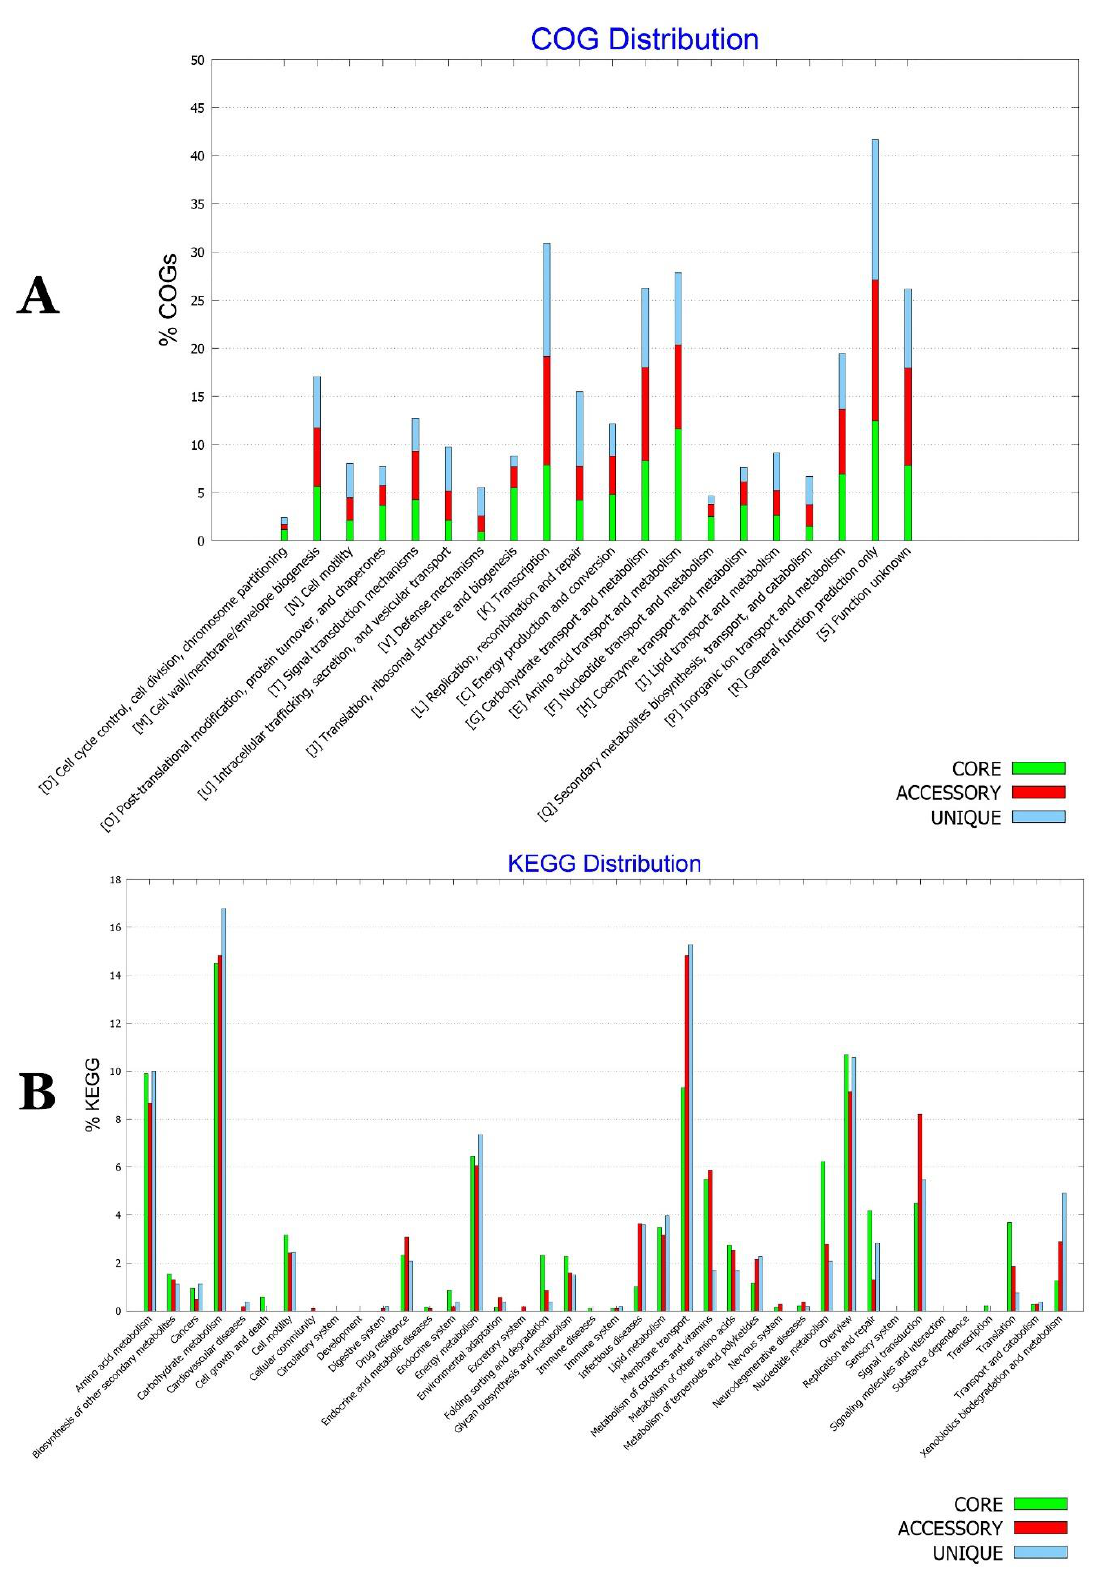
Figure 13. ( A ) COG and ( B ) KEGG distribution for accessory, core and unique genomes of P. agglomerans – P. vagans strains collection.